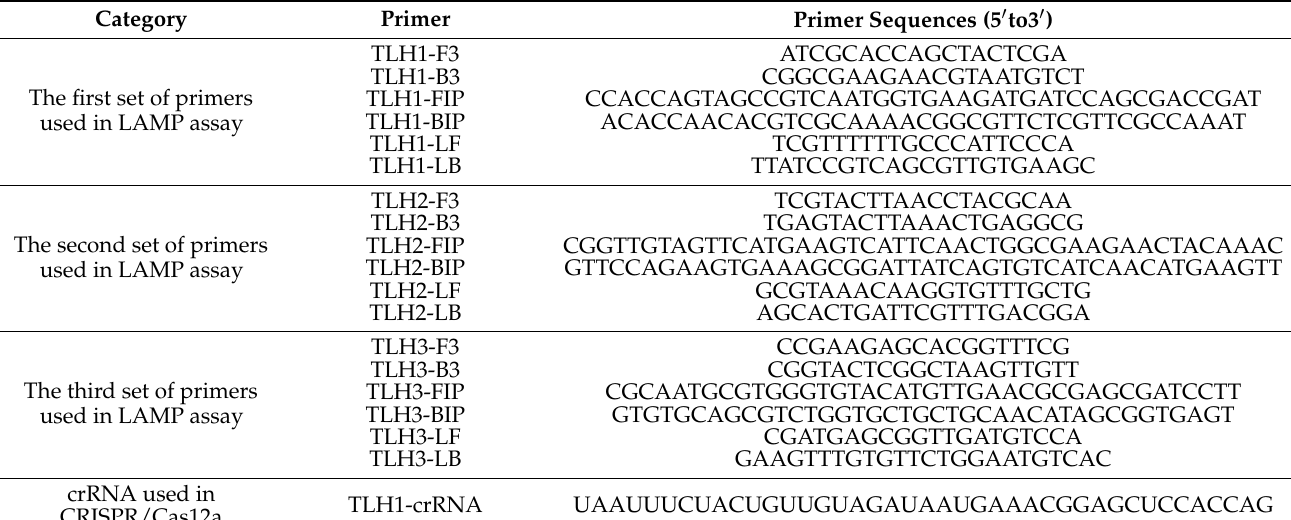
Table 1. Sequences of primers and crRNA.